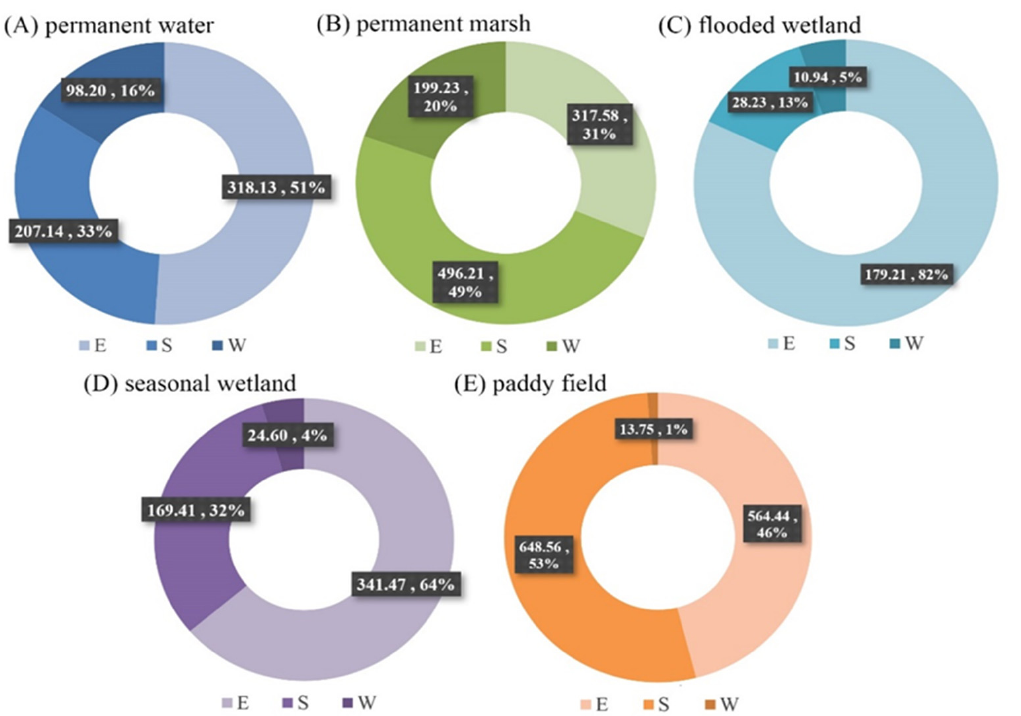
Figure 7. Spatial characteristics of different wetlands in the three Dongting Lake wetland reserves. Note: E represents the East Dongting Lake wetland reserve; S represents the South Dongting Lake wetland reserve; W represents the West Dongting Lake wetland reserve.